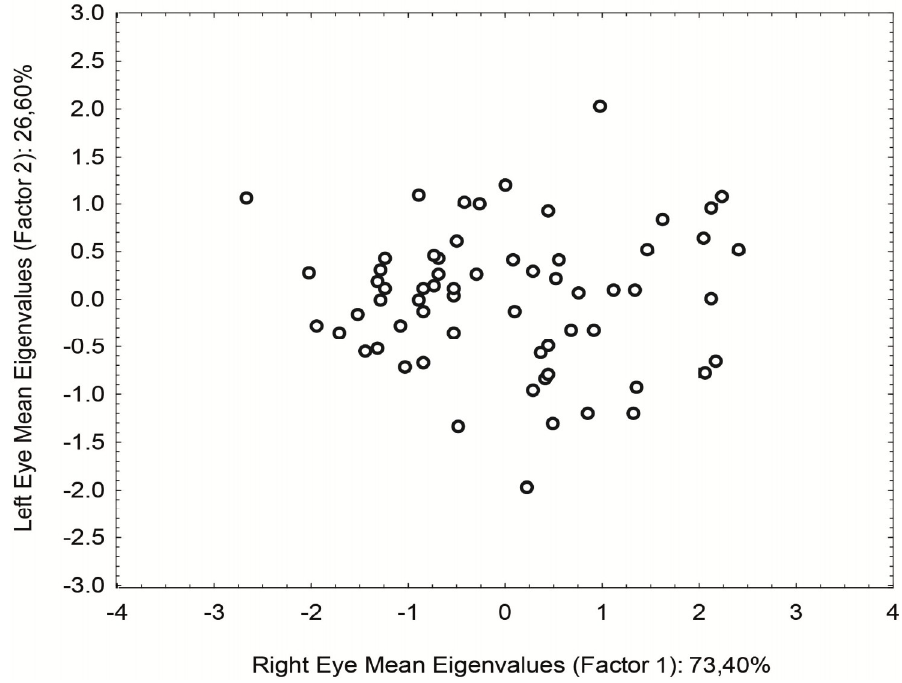
Figure 4. Dispersion of the straylight values from the mean of the 3 measurements performed in right (Factor 1) and left eyes (Factor 2) resulting from the Principal Components Analysis. The right eye showed a higher contribution to the straylight measured.